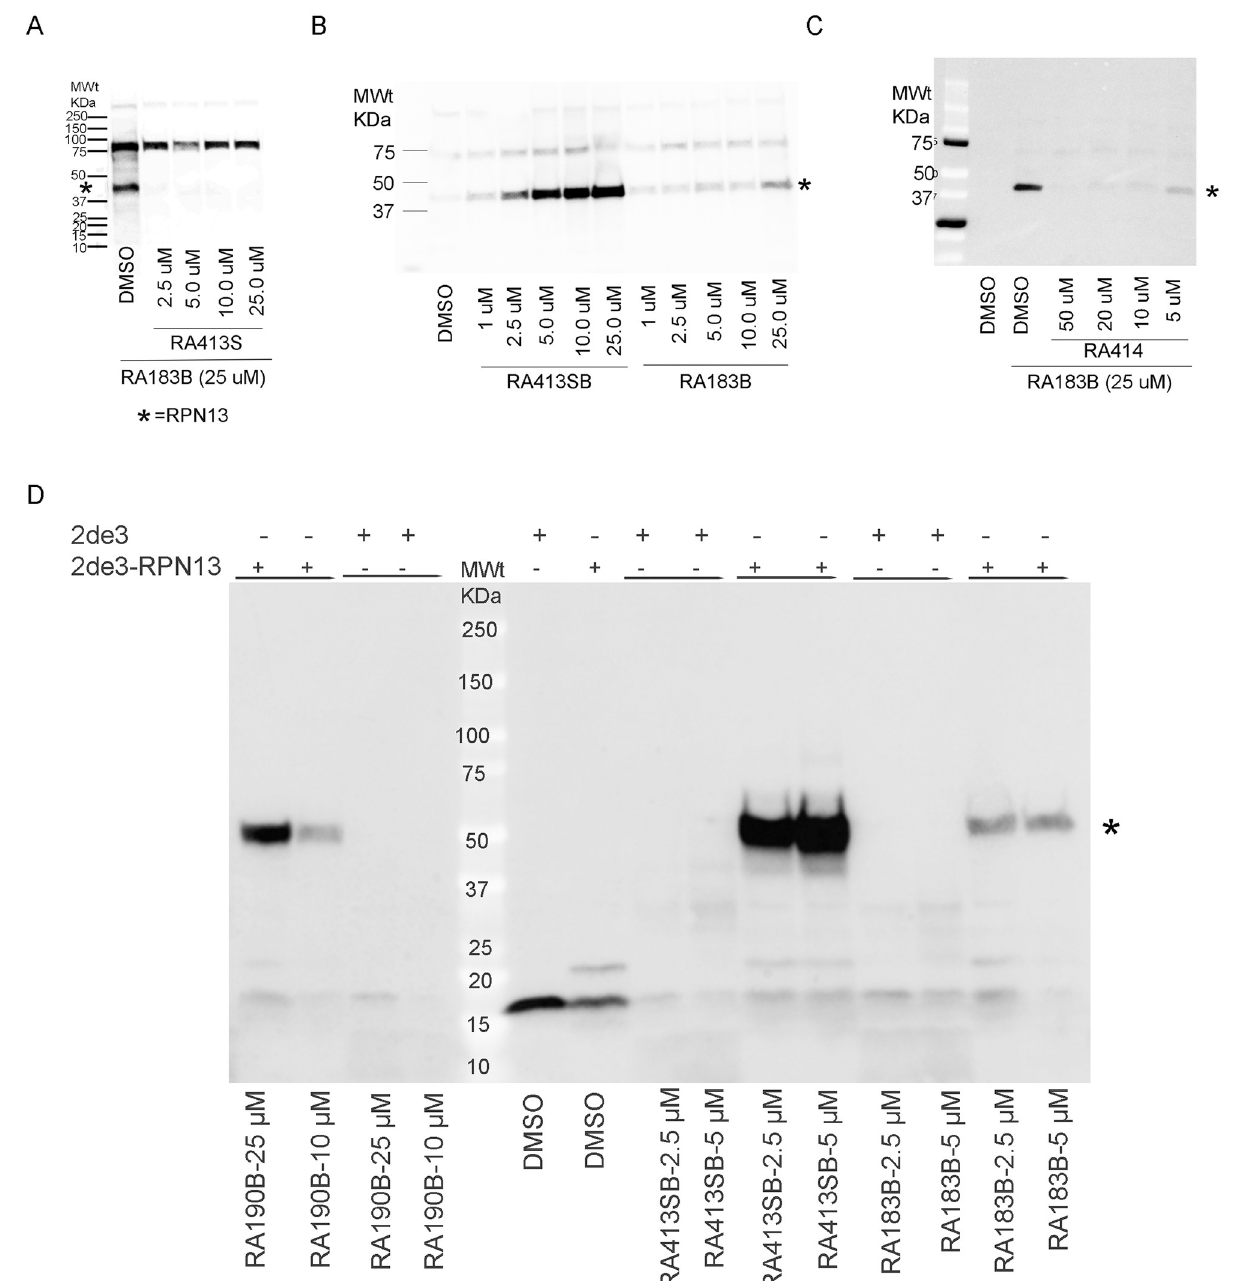
Fig 3. Compounds binding to RPN13 in cell lysate. (A) SKOV3 cell lysate was pretreated with RA413S at indicated concentrations and labelled with RA183B, and (B) ES2 cell lysate was treated with titrations of the biotinylated compound. (C) SKOV3 cell lysate was pretreated with RA414 at various concentrations and labelled with RA183B. (D) Lysate of E. coli 2DE3 overexpressing RPN13 from pET28, or without RPN13 as a negative control, was labelled with 5 μ M of either RA413SB, RA190B or RA183B. In each case, after treatment the samples were separated by SDS-PAGE, transferred to a PVDF membrane which was probed with HRP-streptavidin to detect biotinylated